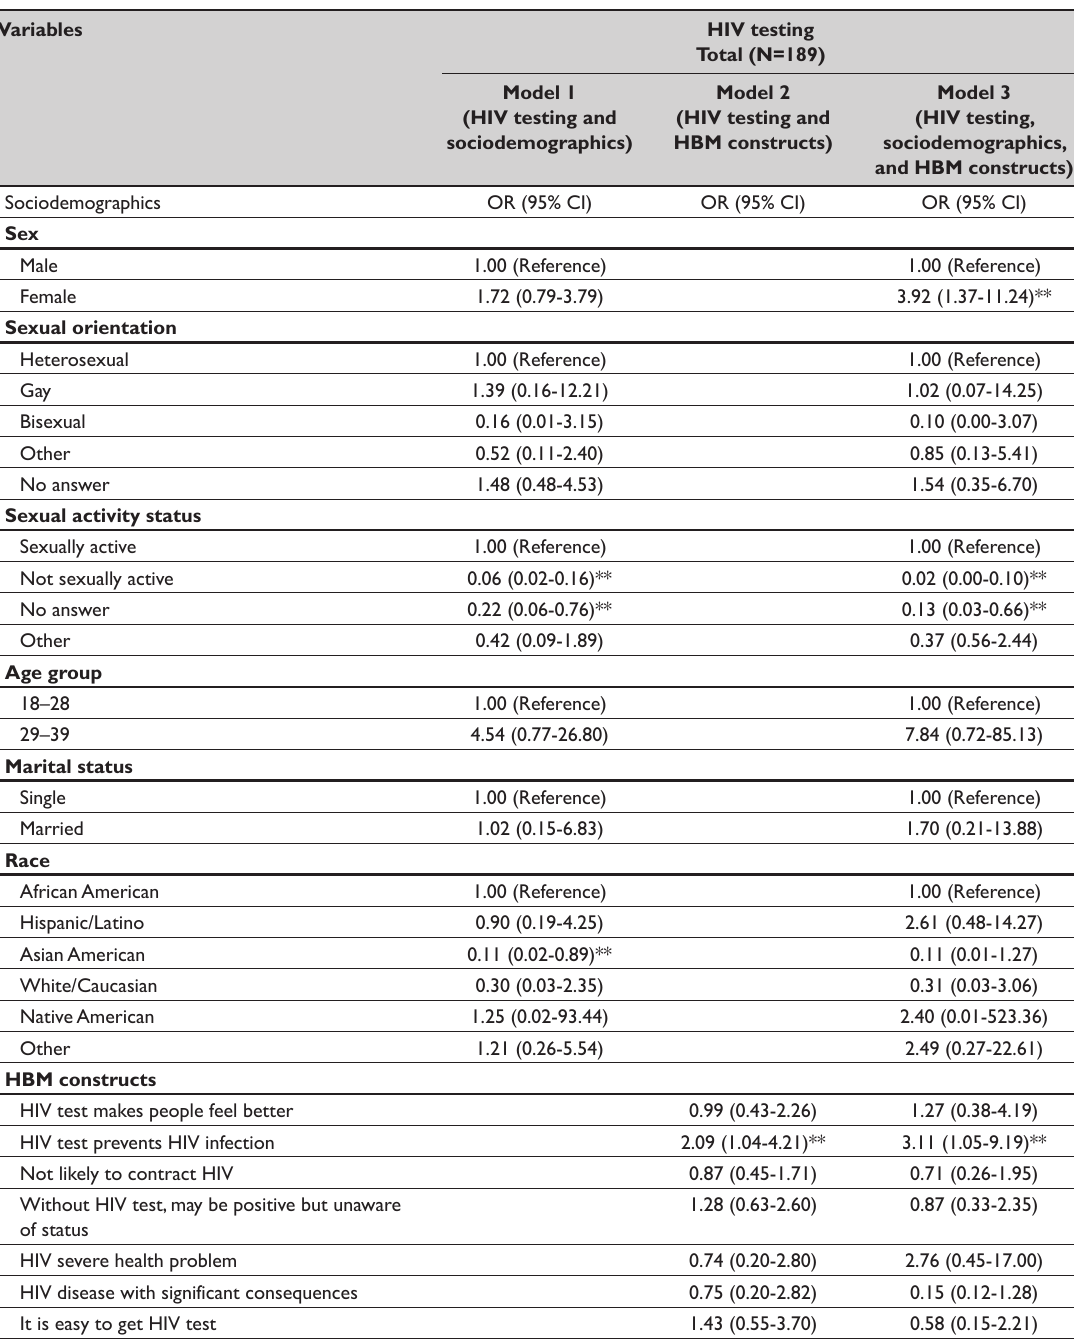
Table 5: Association between selected sociodemographic factors, HBM constructs, and HIV testing among students in a community